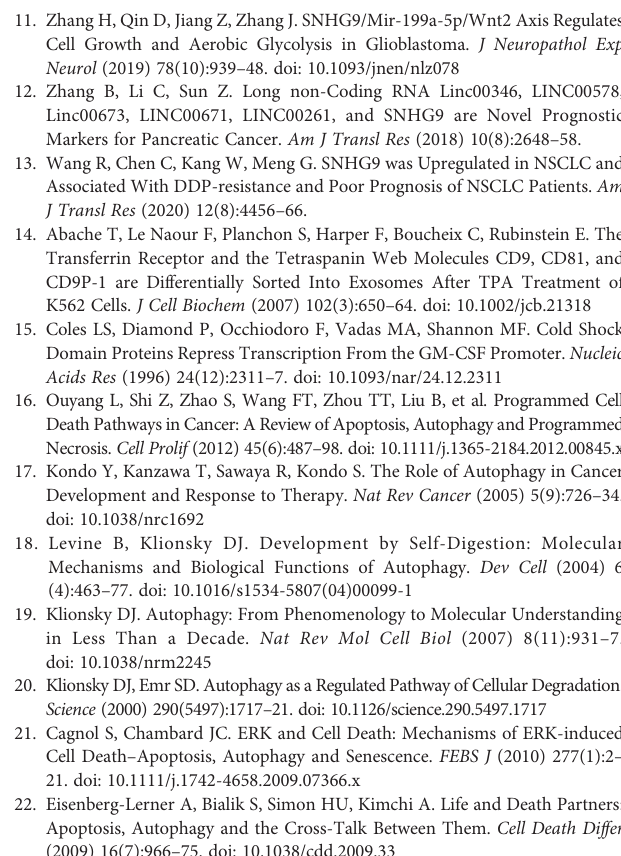
Supplementary Figure 1 | Validation of cell exosomes extraction. (A) Cell exosome marker CD9 and CD63 showed successful cell exosome extraction by Western blotting. (B) The shape of exosomes was observed by transmission electron microscopy. Supplementary Figure 2 | (A, C) Overexpression ef fi ciency of SNHG9 in TPC-1, K-1 and Nthy-ori-3 cell lines con fi rmed by qPCR. (D, F) Knockdown ef fi ciency of SNHG9 in TPC-1 and K-1 cell lines con fi rmed by qPCR. Supplementary Figure 3 | SNHG9 could inhibit Nthy-ori-3 cell autophagy through TPC-1 exosomes. (A, C) TPC-1 SNHG9-O/ TPC -1 SNHG9-KD exosomes could inhibit/promote Nthy-ori-3cellsautophagy detectedby mRFP/mCherry-GFP-LC3B autophagy fl ow. Yellow spots indicate autophagosomes and red spots indicate autophagic lysosomes. (B) P62 was signi fi cantly increased in TPC-1 SNHG9-O exosome treated Nthy-ori-3 and was downregulated in TPC-1 SNHG9-KD exosome treated Nthy-ori-3 cells by Western blotting. (D) The impact of TPC-1 SNHG9-O/ TPC- 1 SNHG9-KD exosomes on Nthy-ori-3 cell autophagy was decreased after TPC-1 cell exosomes secretion was inhibited by GW4869. (E) P62 protein change after TPC-1 cell exosomes secretion was inhibited by GW4869. Supplementary Figure 4 | SNHG9 could promote Nthy-ori-3 cell apoptosis through TPC-1 exosomes. (A, B) TPC-1 SNHG9-O/ TPC-1 SNHG9-KD exosomes could promote/inhibit Nthy-ori-3 cells apoptosis detected by fl ow